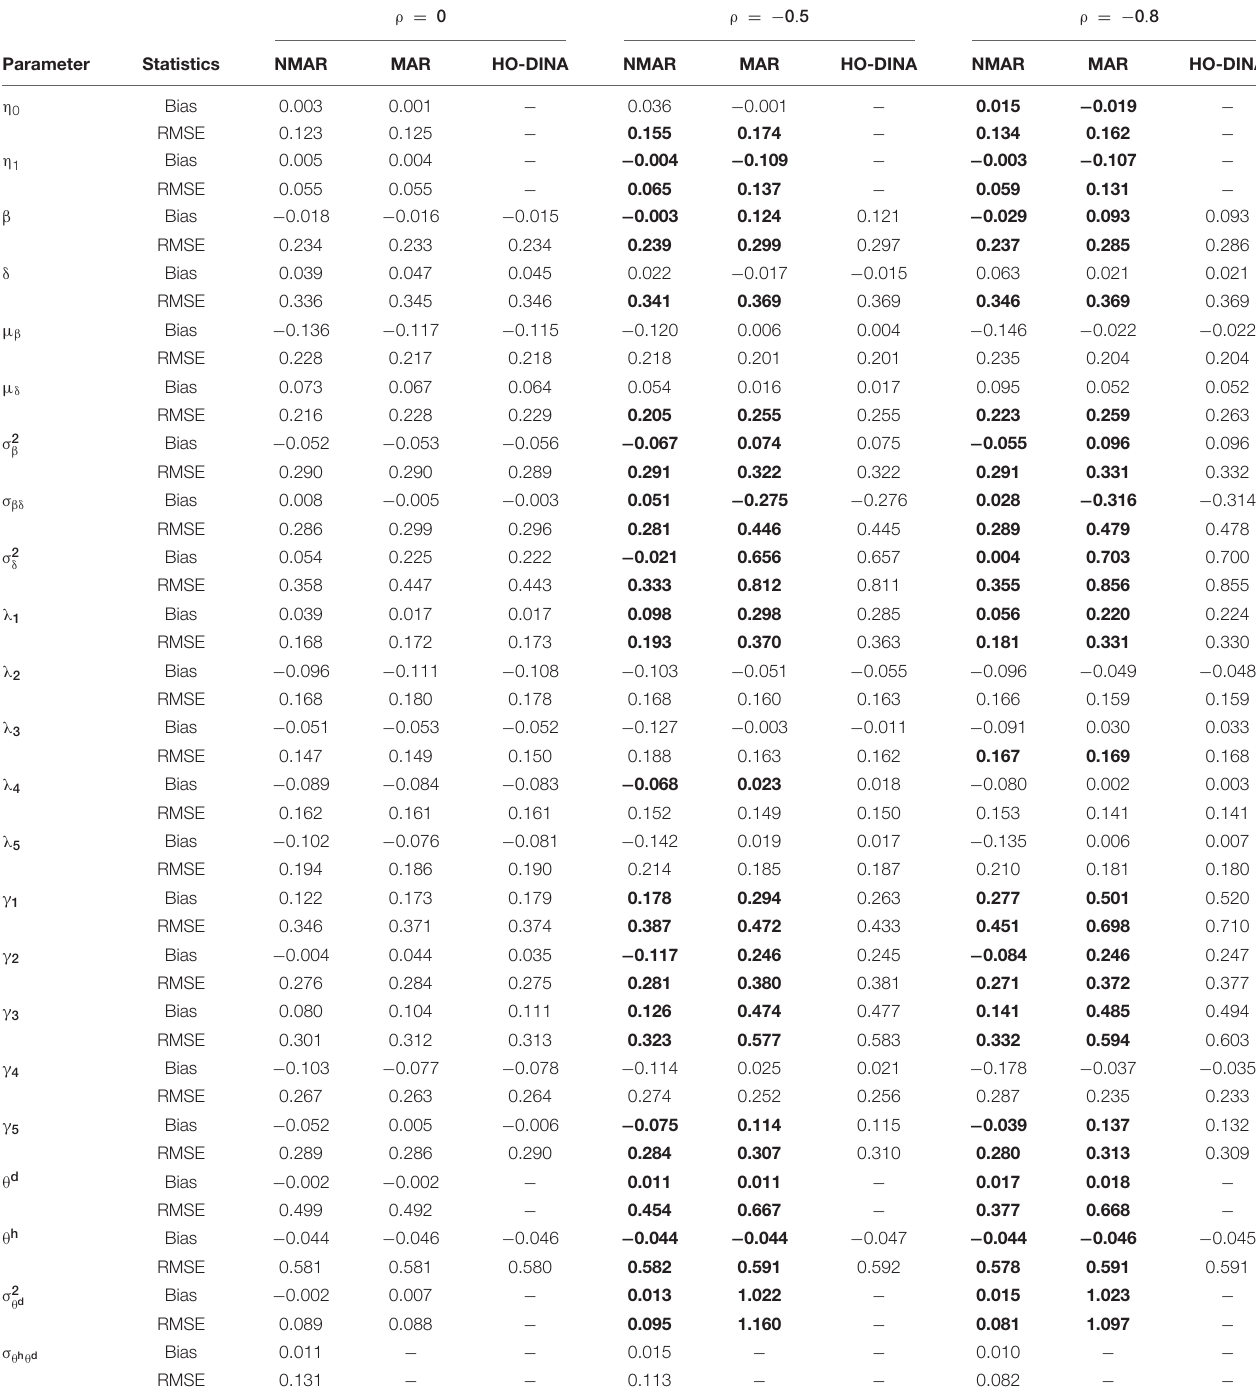
TABLE 3 | Bias and RMSE of parameter estimates of three models with low dropping-out proportion under different correlations between θ h i and θ d i in simulation study III. ρ = 0 ρ = − 0 . 5 ρ = − 0 .